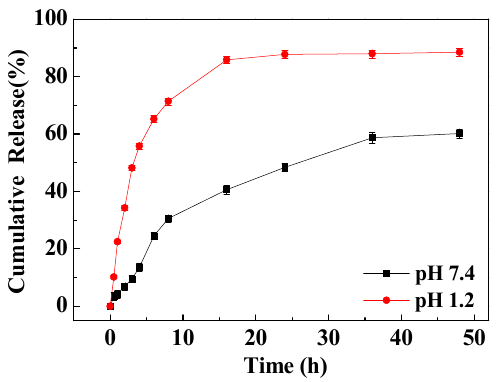
Figure 7. Cur release profiles of Cur/FA-AmCS-TPP nanoparticles in SGF (pH 1.2) and SCF (pH 7.4).